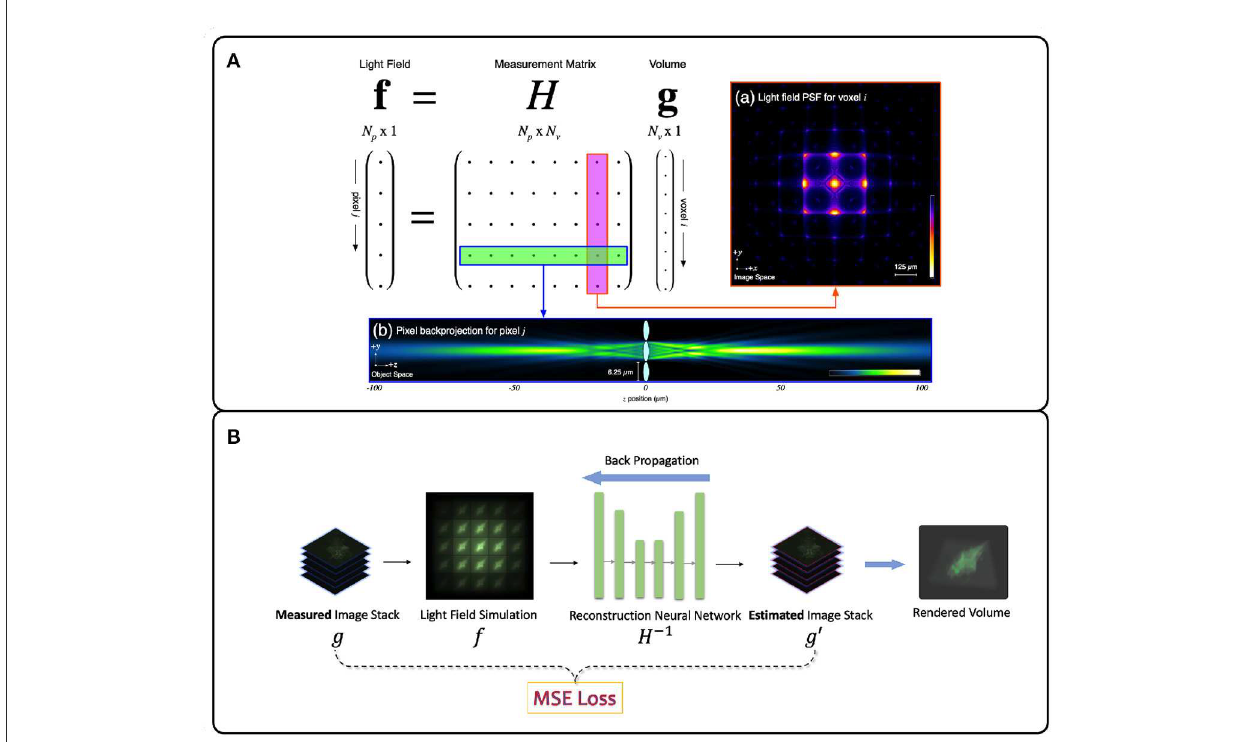
FIGURE4 Illustration of deconvolution algorithms for LFM. (A) Model-driven methods explicitly form the optical transfer matrix H from PSFs and inversely solve the volume vector g from the light field measurement f . Due to the large size of the matrix H , iterative methods such as Richardson-Lucy (Richardson, 1972; Lucy, 1974) are usually adopted (Broxton et al., 2013). (B) Data-driven methods implicitly model the measurement matrix H by training a neural network to learn the mapping relationship between the light field images and the target volumes from the large light field-volume pairs dataset. The mean-square error (MSE) is usually adopted to provide the loss between the predicted volume and the ground truth volume. The loss then backpropagates to update the neural network weights during the training stage. (A) adapted with permission from Broxton et al. (2013) ©The Optical